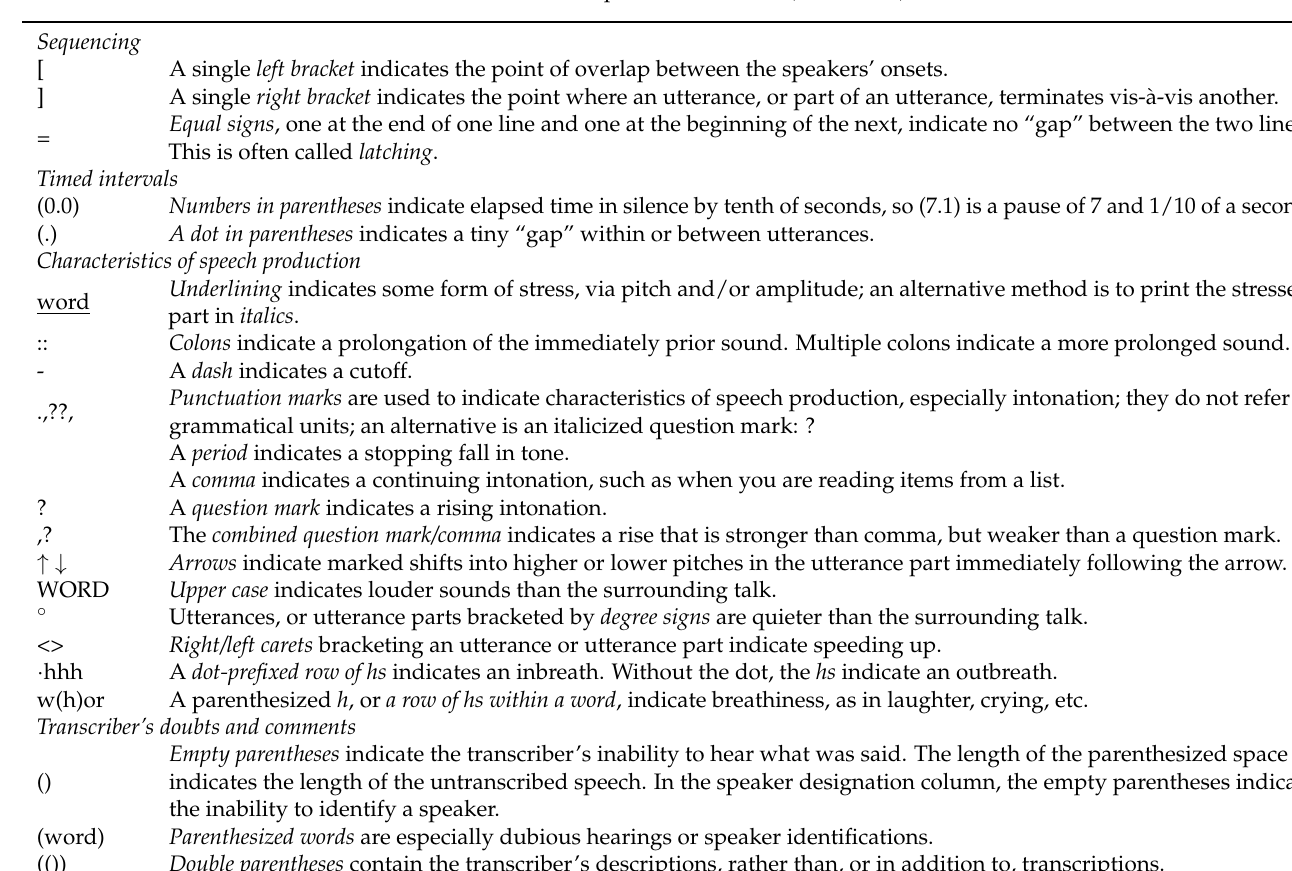
Table 2. Transcription conventions (Have